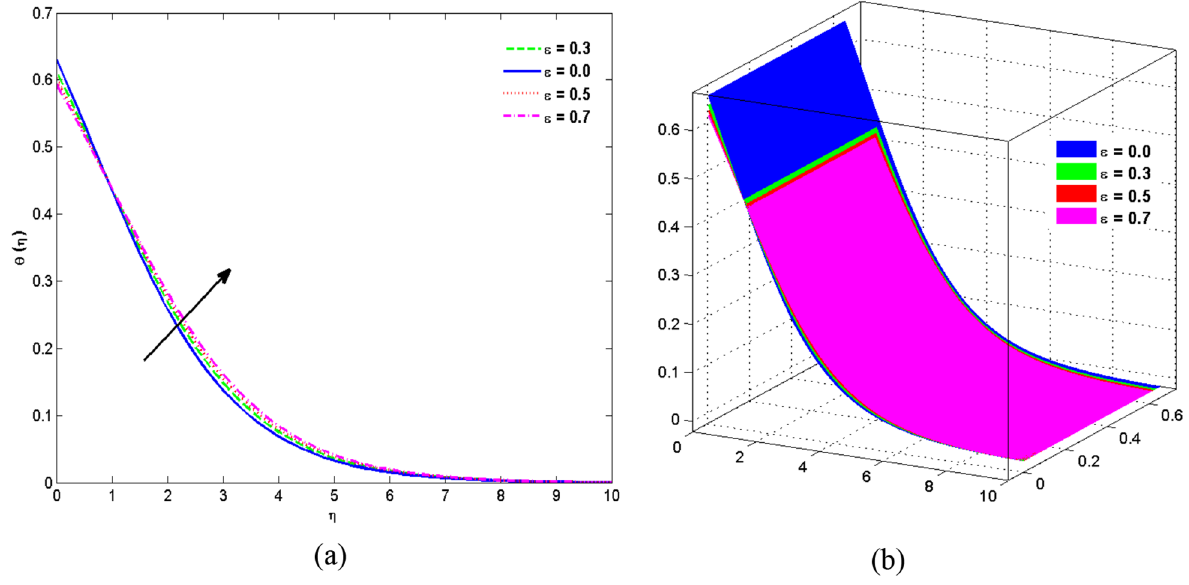
Figure 7. Variations of ε to θ(η) .